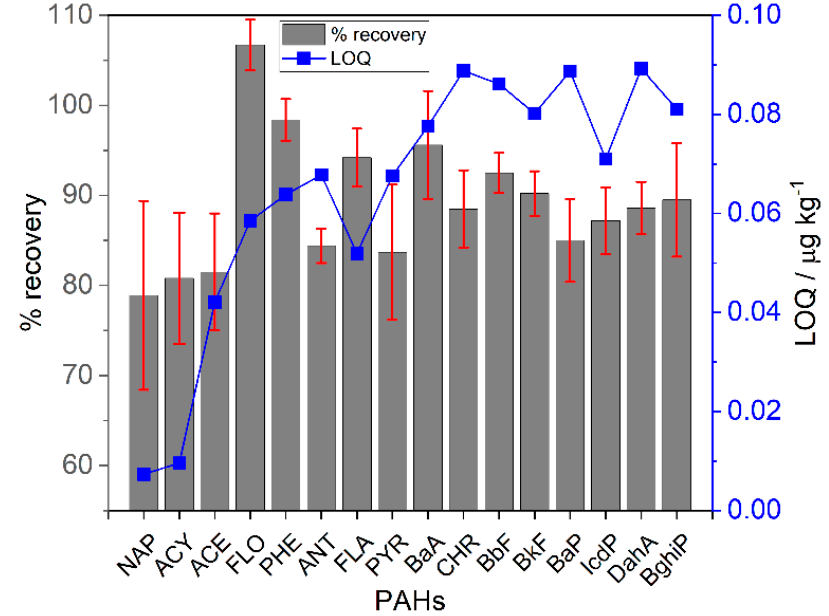
Figure 2. % recovery and LOQ of the soil